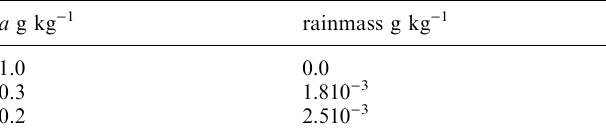
Table 1. Rainmass with varying autoconversion thresholds in a simulated stratocumulus cloud from Jonas and Ghosh (1997) a g kg )